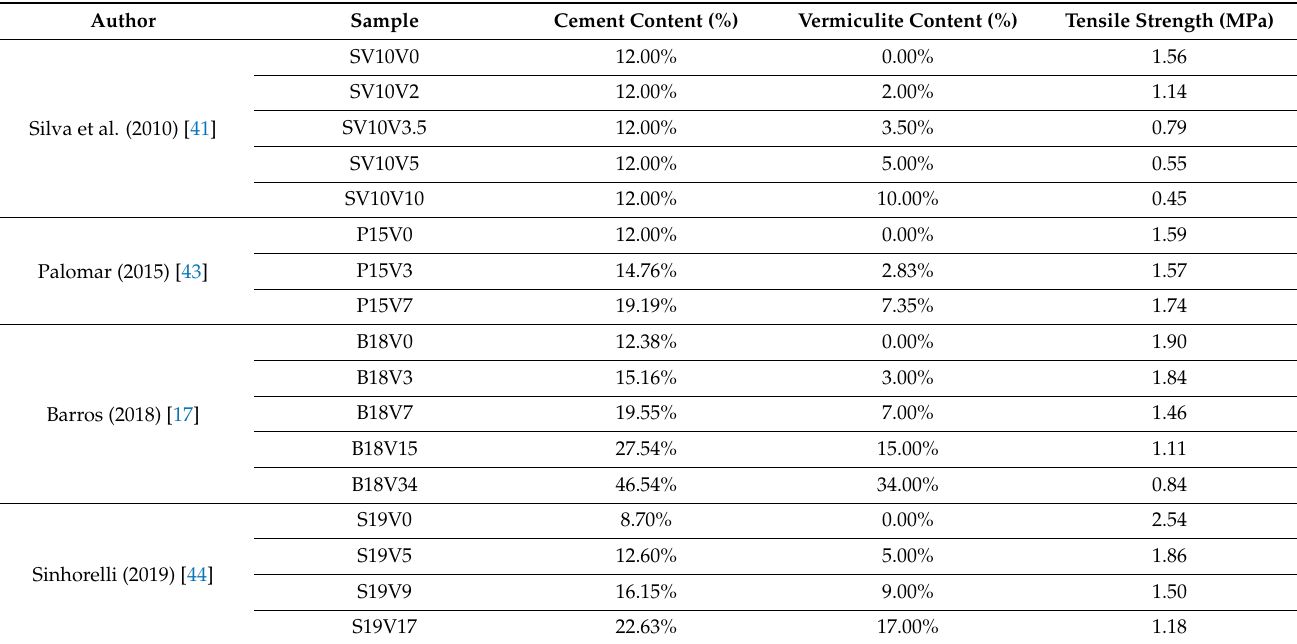
Table 11. Values of flexural strength and cement and vermiculite content of the studied articles